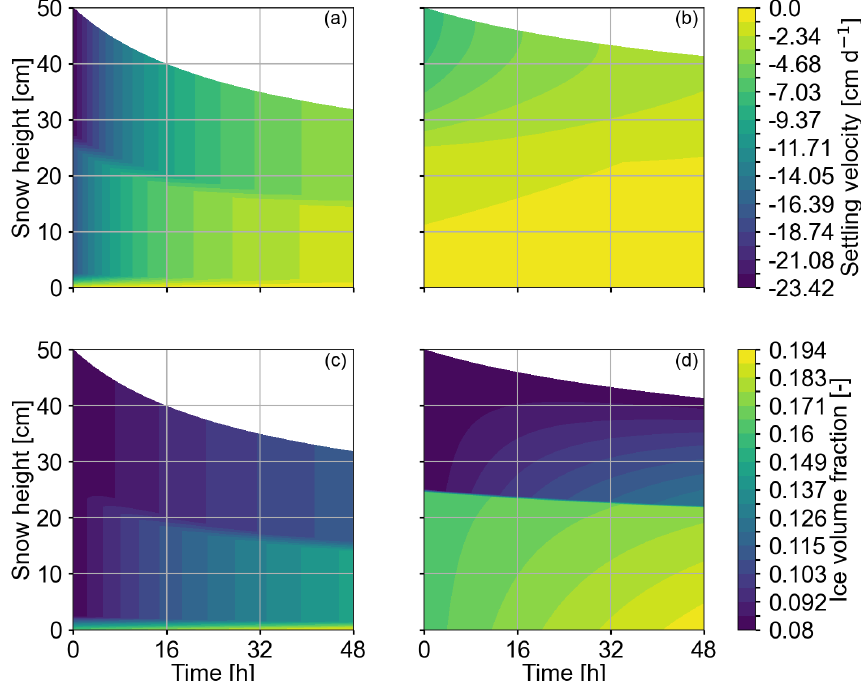
Figure 12. The plots show the temporal evolution of vertical velocity (top row) and the ice volume fraction (bottom row) for Case 6 of Table 2 corresponding to solely active mechanical settling. The y axis depicts snow height. For (b) and (d) , we applied our highly discretized settling scheme, and for (a) and (c) , we mimicked the layerwise discretization of layer-based schemes. Snow viscosity is controlled by the ice volume fraction alone, since heat transport is inactive. In (a) and (c) the lower and upper layer are resolved as the darker upper and brighter lower parts of the snowpack. Their respective values refer to the computational nodes at the top and between the two layers. The values retrieved for the lowest node do not represent an entire layer and are depicted at height zero. For the layer-based scheme, one velocity or ice volume fraction value represents the movement or density of the entire layer. In contrast, with our approach vertical velocity varies throughout each layer in (b) so that the ice volume fraction increases within layers and develops a gradual pattern (d) . For (b) and (d) , we interpret the locations of the upper and lower layers as the darker upper and brighter lower areas, respectively, in (d)